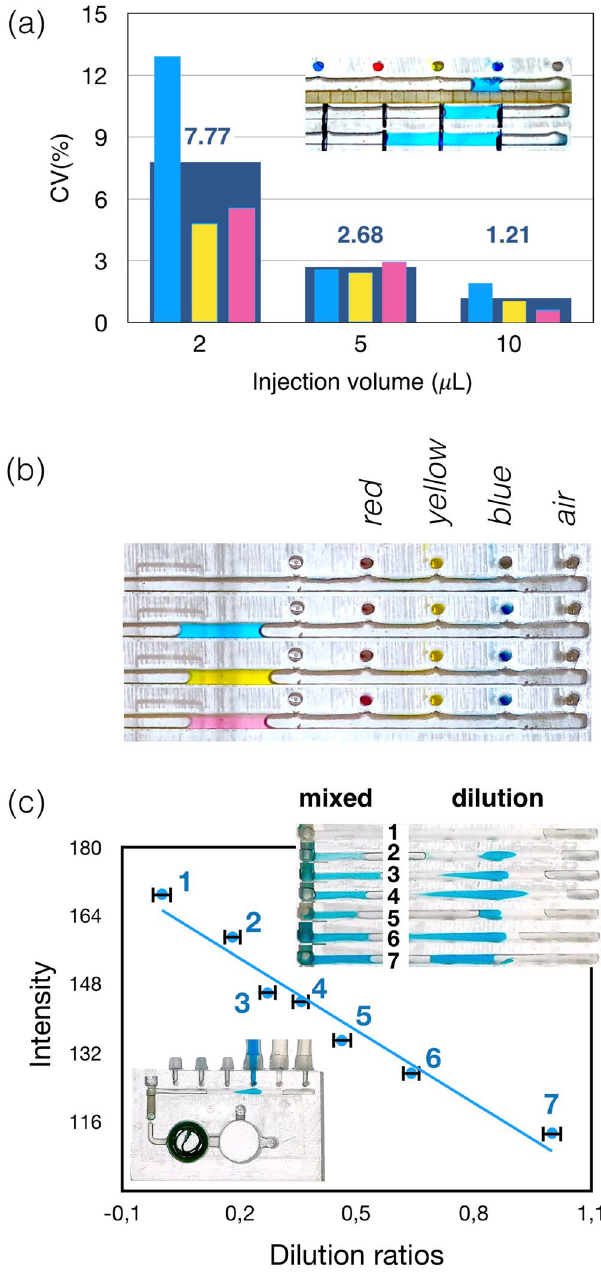
Figure 2. ( a ) Reliability of the injectors expressed as coefficient of variation for injection volumes between 2 and 10 μ L. ( b ) Zoomed area of the manifold underscoring the null dead volume check valves characteristic as the absence of contamination between injectors and manifold when 5 μ L volumes flow along the manifold. ( c ) Performance of the unidirectional manifold for sample